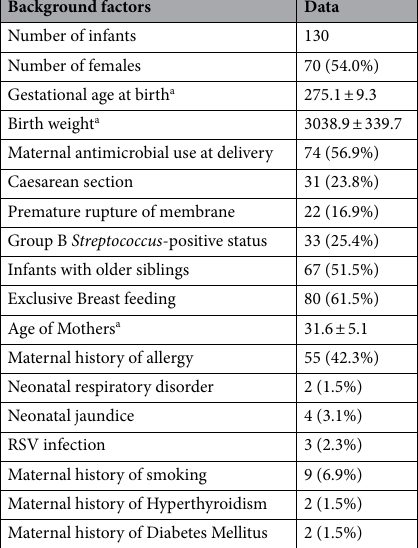
Table 1. Background factors of 1-month-old infants and their mothers. RSV respiratory syncytial virus. a Gestational age at birth, birth weight, and maternal age are shown as the mean ± standard deviation. Other factors are given as the number of subjects and a percentage.